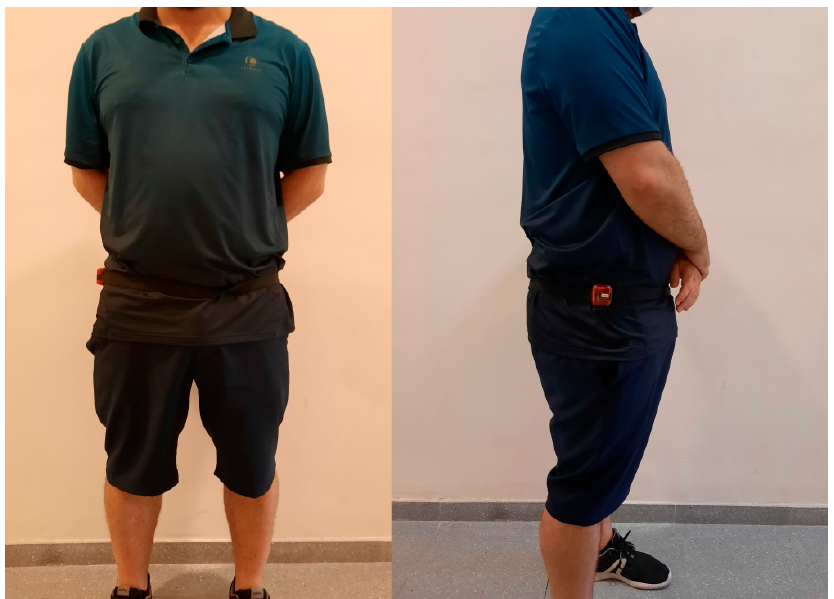
Figure A1. Actigraph gt3x position.